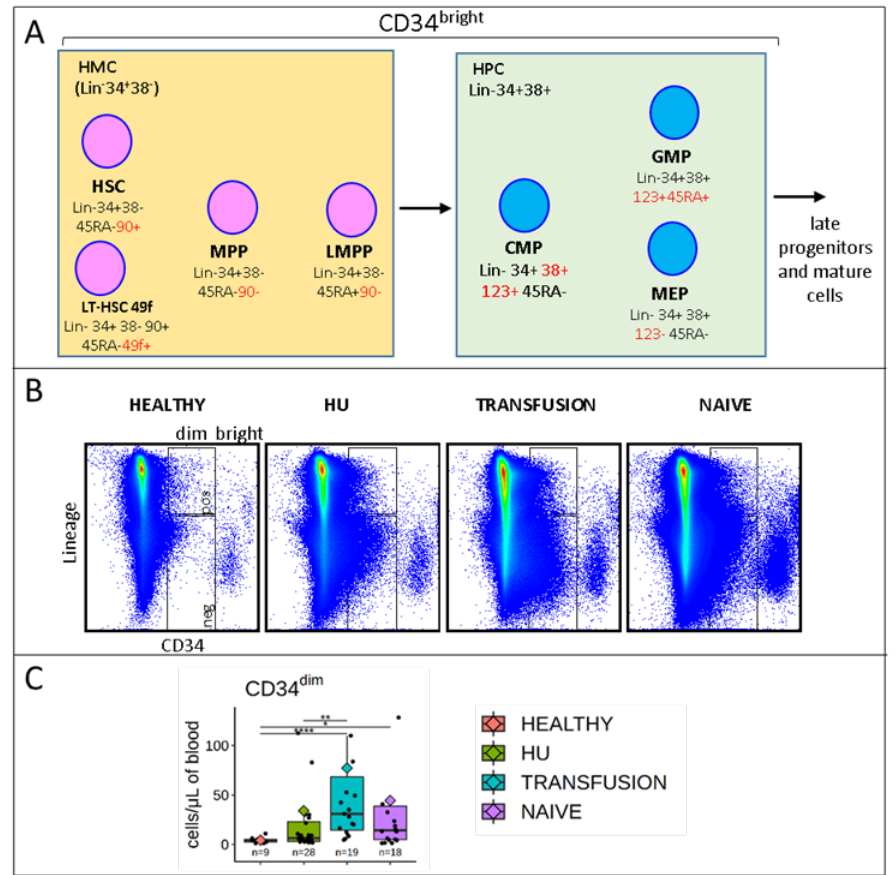
Figure 1. CD34 dim cells are elevated in sickle cell disease (SCD): ( A ) Diagram illustrating the 9 populations of hematopoietic stem and progenitor cells (HSPCs) quantified in this report. The Hematopoietic Multipotent Cell (HMC) population encompasses 49f cells, 90 + 45RA − , MPPs, and LMPPs; the Hematopoietic Progenitor Cell (HPC) population includes the Common Myeloid Progenitors (CMPs), Granulocyte Macrophage Progenitors (GMPs), and Megakaryocyte-Erythroid Progenitors (MEPs). HMCs and HPCs di ff er in part by expression of CD38. ( B ) High number of CD34 dim cells in SCD patients: Dot plots illustrating the flow cytometry assays. (Healthy, HU = Hydroxyurea treated, Transfusion = treated by chronic transfusion, or Naïve = treatment free). FCS files were concatenated (10,000 cells per patient) and plotted to visualize expression of CD34 and lineage antigens. ( C ) Boxplots summarizing the concentration of CD34 dim cells per µ L of blood. The box outlines the first and third quartiles. The horizontal bar represents the median; the diamond represents the mean. Significance was calculated using the Wilcox test (with FDR correction). ns: p > 0.05; * p ≤ 0.05; ** p ≤ 0.01; **** p ≤ 0.0001.